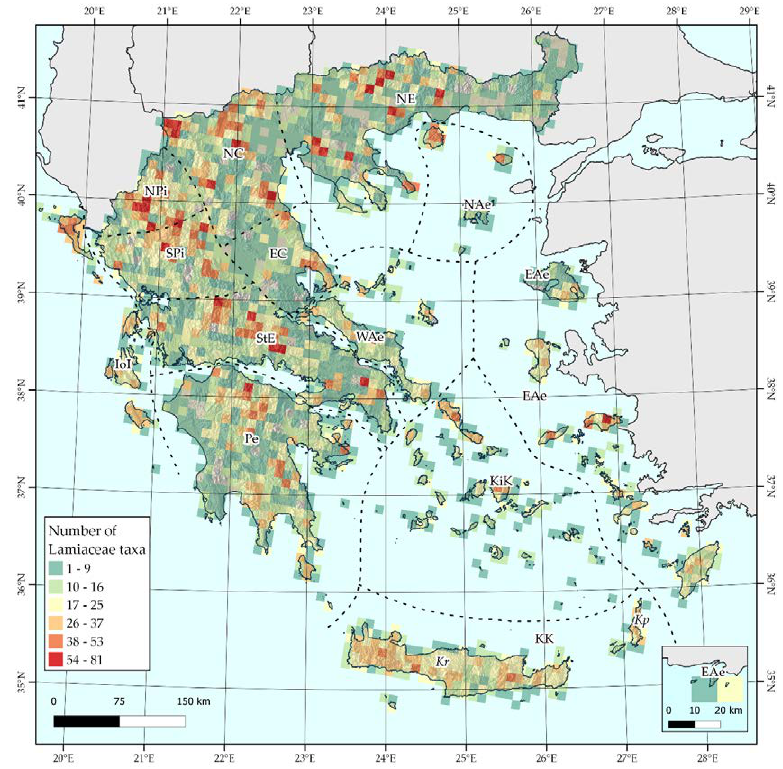
Figure 3. Distribution of the Lamiaceae taxa in Greece (10 × 10 km, EEA reference grid). Dotted lines delineate the floristic regions of Greece [44]. Forests 2020 , 11 , x FOR PEER REVIEW